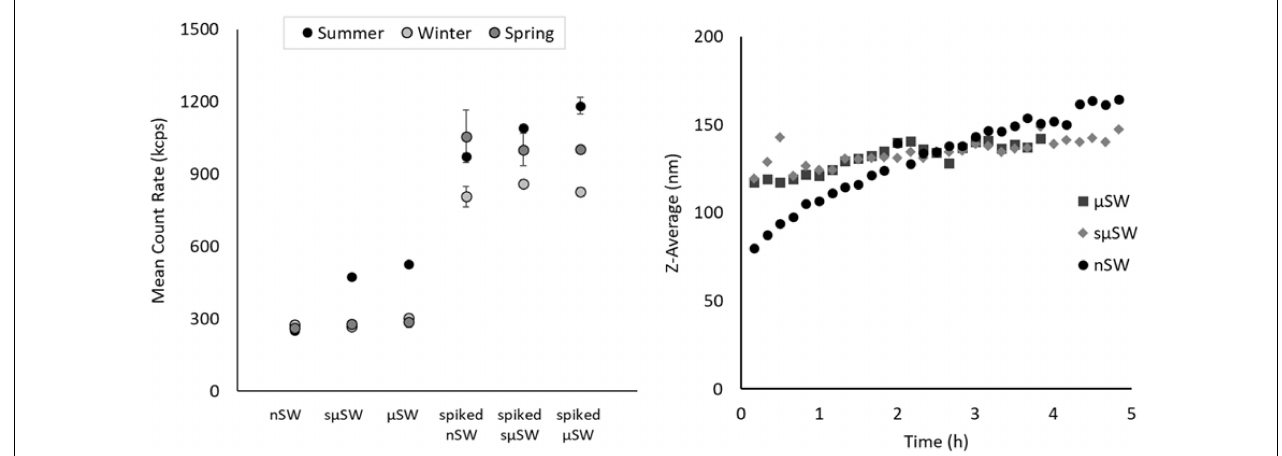
FIGURE 1 | Intensity of scattered light (measured with DLS) for nSW, s µ SW, and µ SW before and after spiking with Au ENPs in seawater collected during the summer, winter, and spring season (left) . Marker and error bars for non-spiked samples represent the average and standard deviation of three measurements, while marker and error bars for spiked samples represent the average and deviation between duplicate measurements. Intensity-based hydrodynamic diameter (Z-average) of summer seawater spiked with Au ENPs within 5 h from the time of spiking (right)